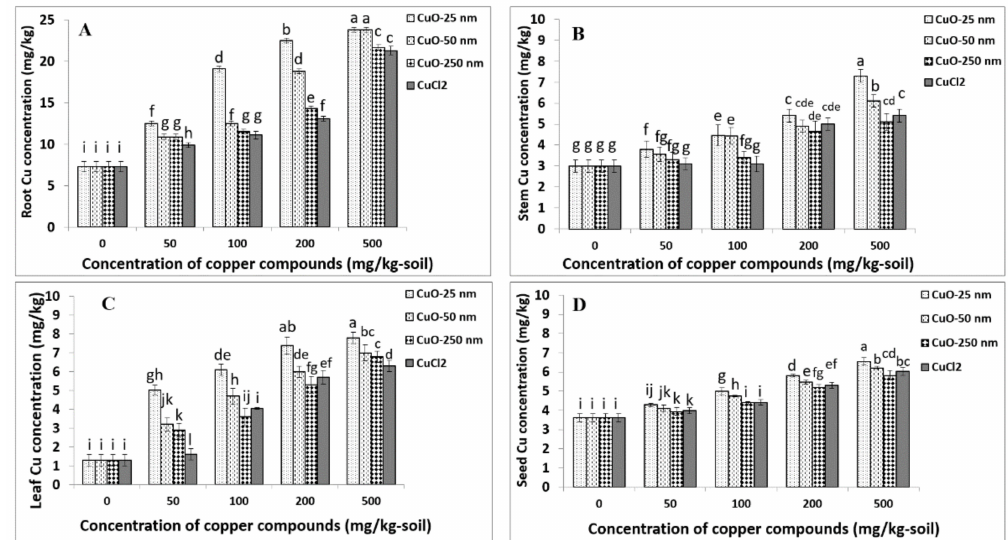
Figure 4. Cu uptake in soybean root ( A ), stem ( B ), leaf ( C ), and seed ( D ) upon exposure to soil amended with CuONP–25 nm, CuONP–50 nm, CuONP–250 nm, and CuCl 2 , at di ff erent concentrations. Same letter above the bars indicates no significant di ff erence according to the Fisher’s LSD test at p ≤